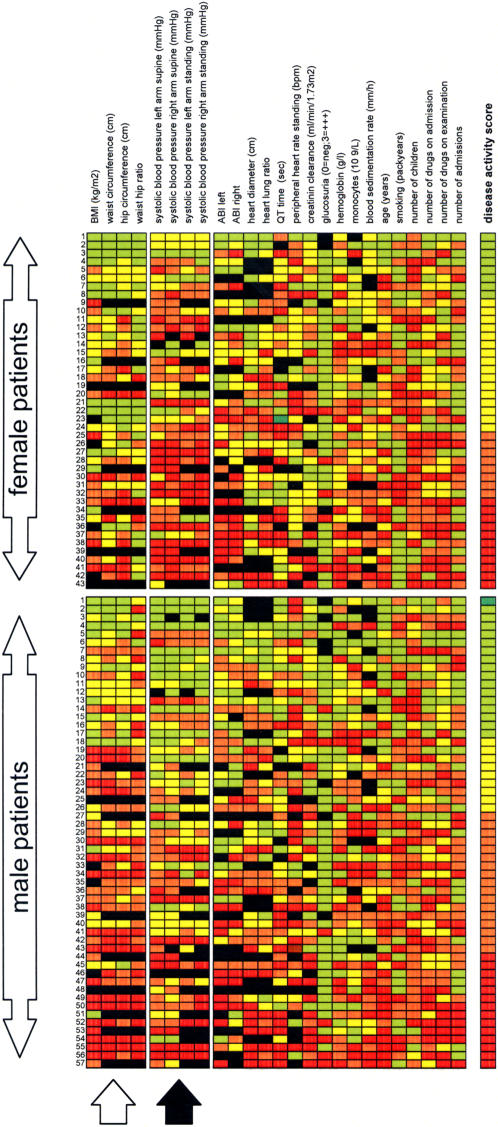
The clinical disease array.The color-coded empiric clinical disease profiles (see Figure 1B) of the 43 female and 57 male symptomatic patients were aligned and sorted according to disease activity score. Male and female patients were significantly different in anthropometric (white arrow) and blood pressure data (black arrow).